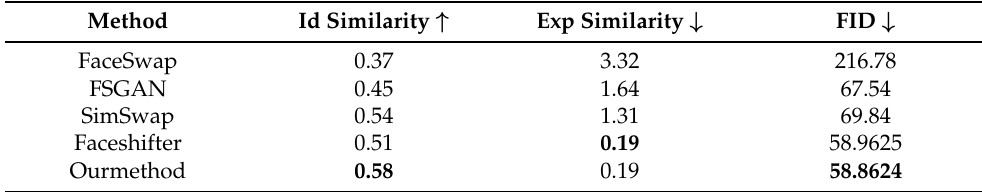
Table 2. Quantitative analysis of the comparative experiment with other method. Bold represents the optimal